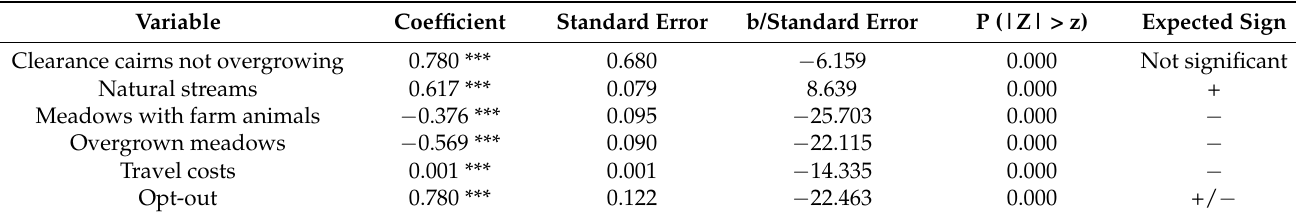
Table 4. Parameter estimates within the multinomial logit model (source: